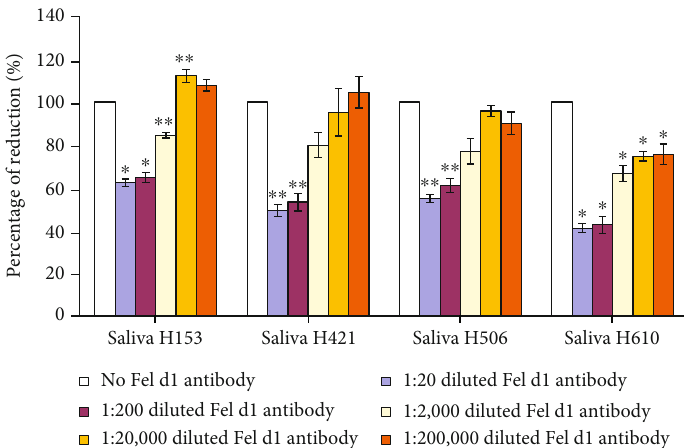
Figure 3: Beta-hexosaminidase release assay with multiple cat saliva samples. The Indoor Poly antibody dose-dependently reduced Fel d1-to- IgE binding and mediator release in multiple cat saliva samples. Although responses di ff ered across samples, there was a dose-dependent decrease in mediator release across saliva samples at dilutions to 1:200 ( p < 0 : 05 ). ∗ Signi fi cantly di ff erent from control ( p < 0 : 001 ). ∗∗ Signi fi cantly di ff erent from control ( p < 0 : 05 ).